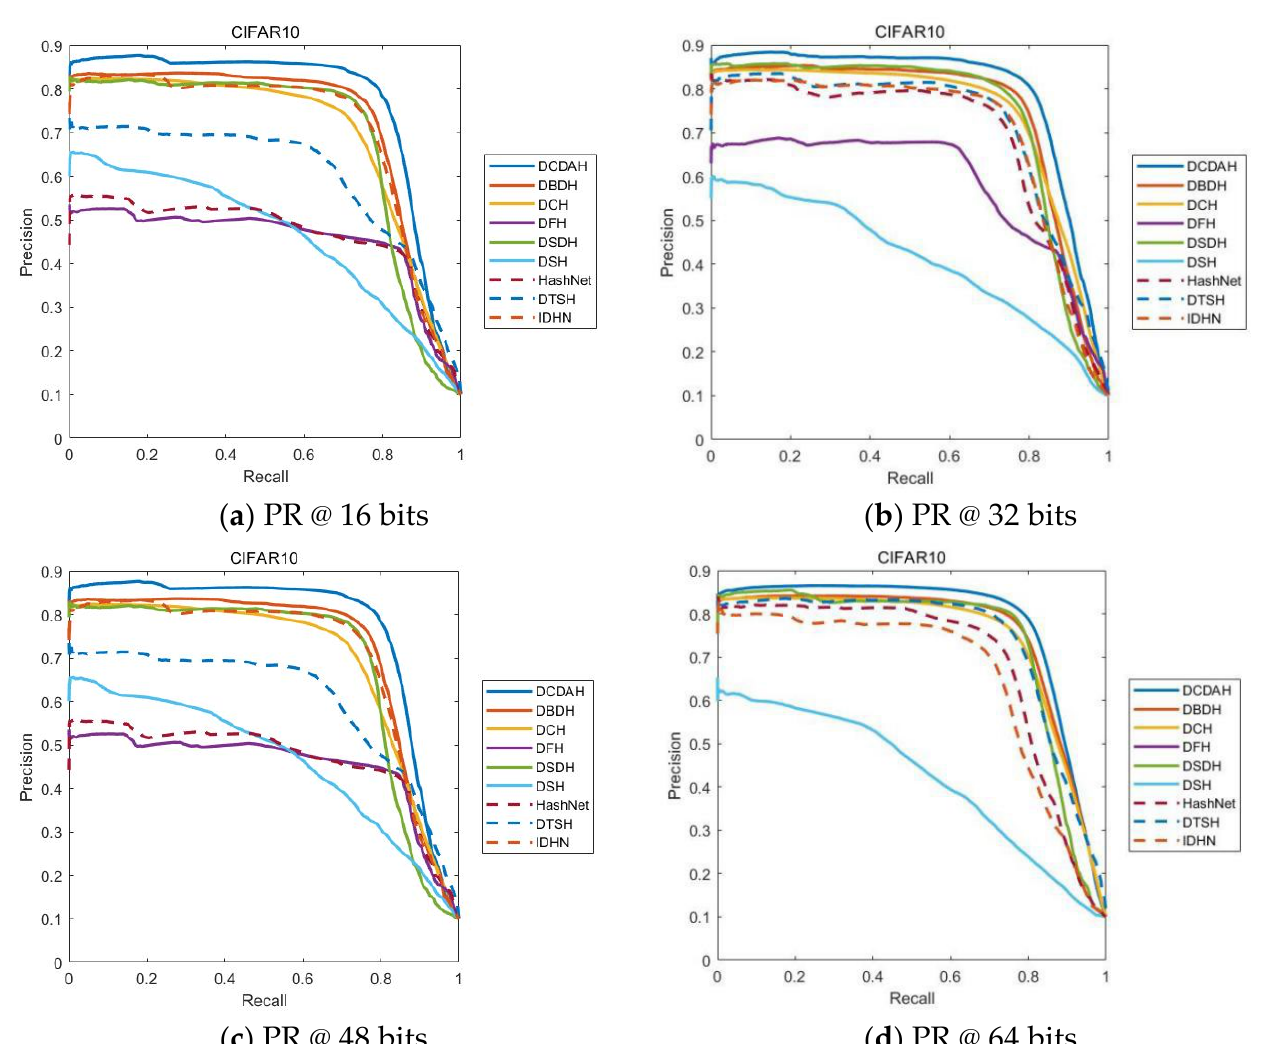
Figure 5. PR curves of all algorithms on CIFAR10 when the hash code takes 4 different lengths.